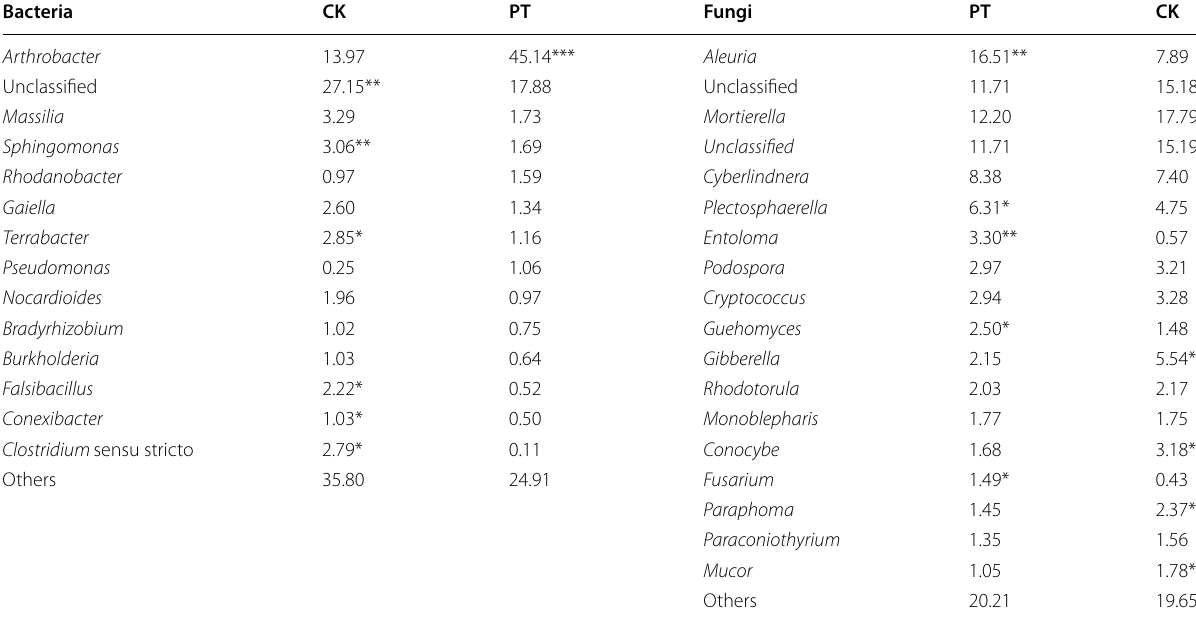
Table 2 The differences for microbial community compositions of tobacco rhizosphere between the CK and PT treatments at the genus